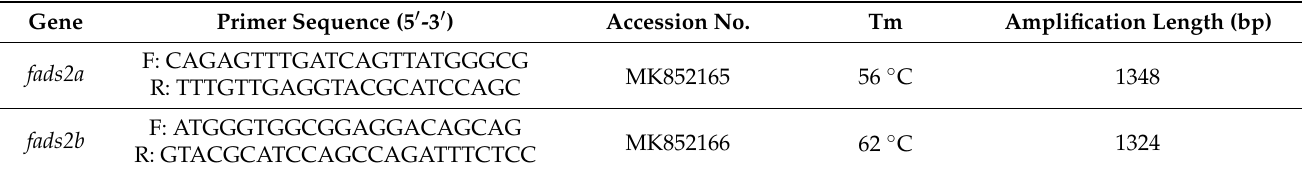
Table 1. The primers used for amplification of the CDS regions of fads2a and fads2b . Gene Primer Sequence (5 (cid:48) -3 (cid:48) ) Accession No. Tm Amplification Length (bp) F: fads2a